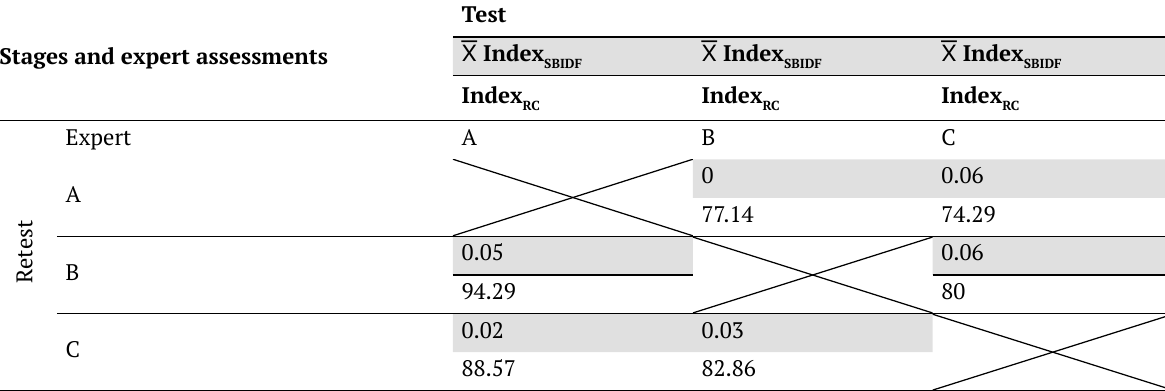
scores and rating compatibility index Index SBIDF